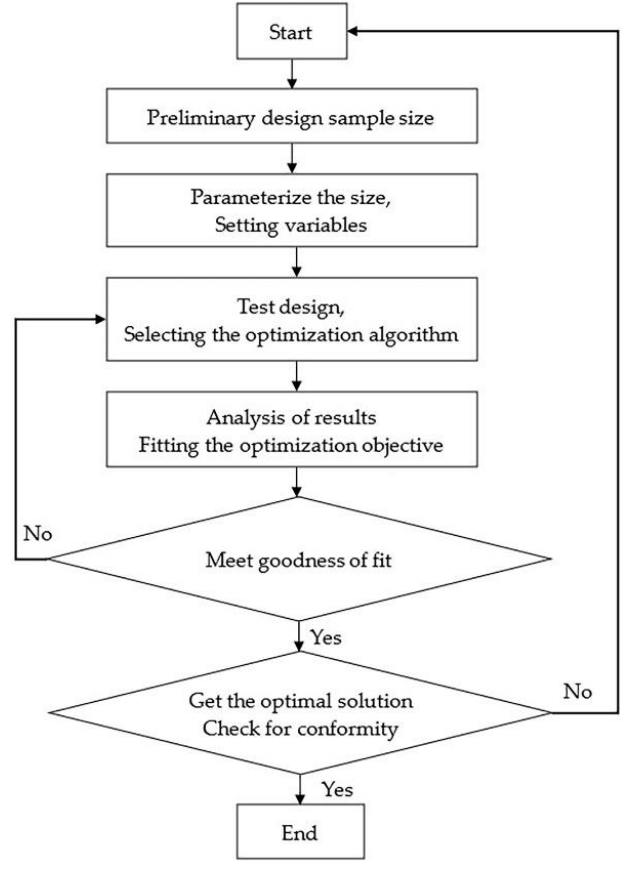
Figure 6. Flow chart for sample optimization design.